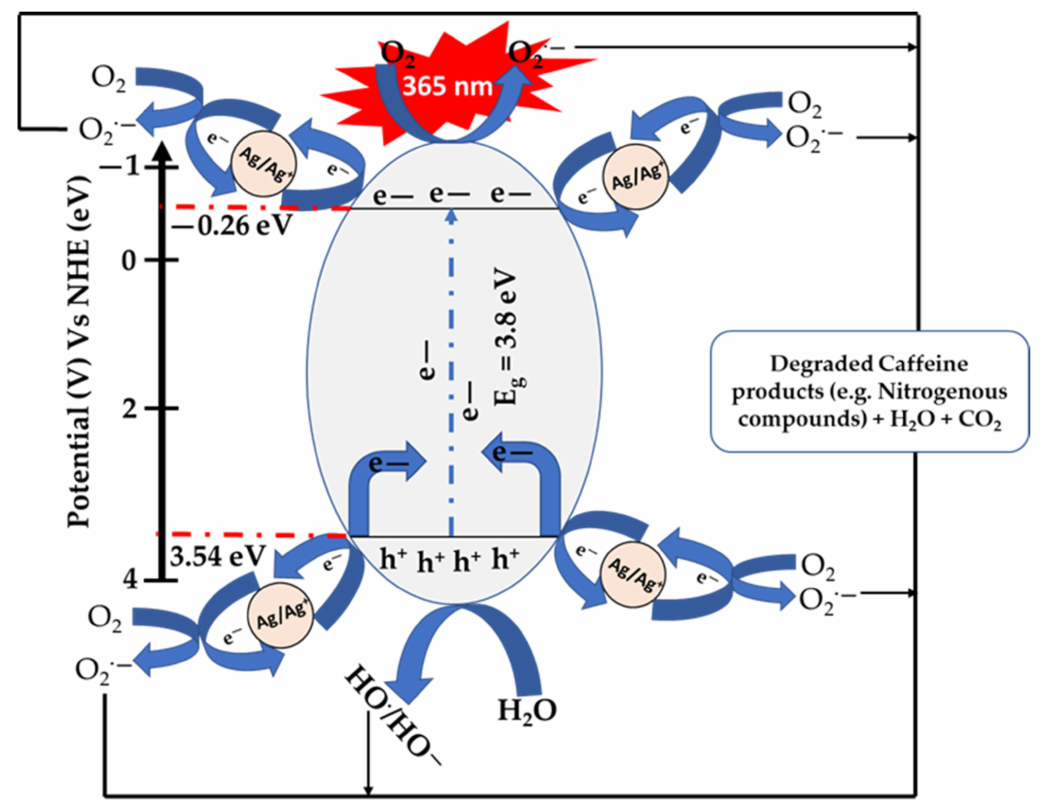
Scheme 1. Proposed Reaction Mechanism of Ag-ZnSnO 3